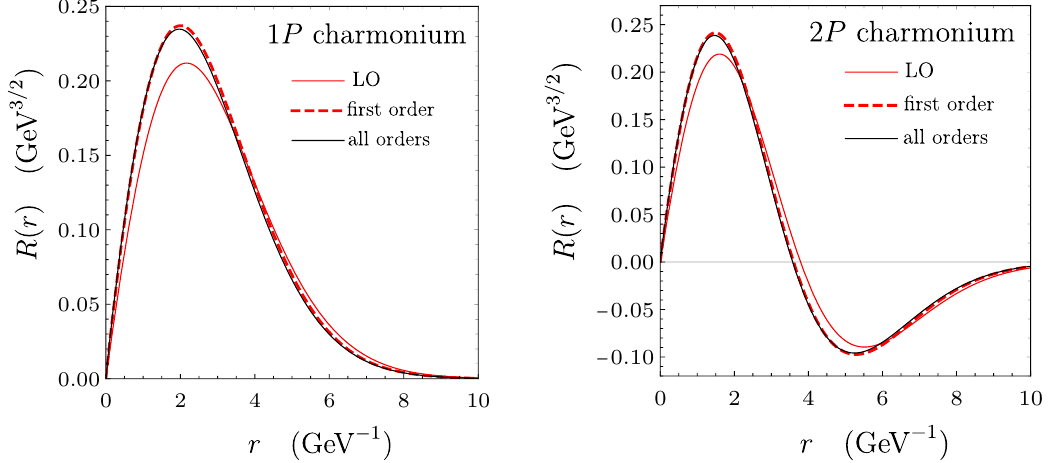
Figure 5 . Radial wavefunctions for 1 P and 2 P states including the effect of the 1 /m potential to first order in Rayleigh-Schrödinger perturbation theory (red dashed lines) compared to the all- orders calculation (black solid lines). The LO radial wavefunctions are shown as red solid lines for